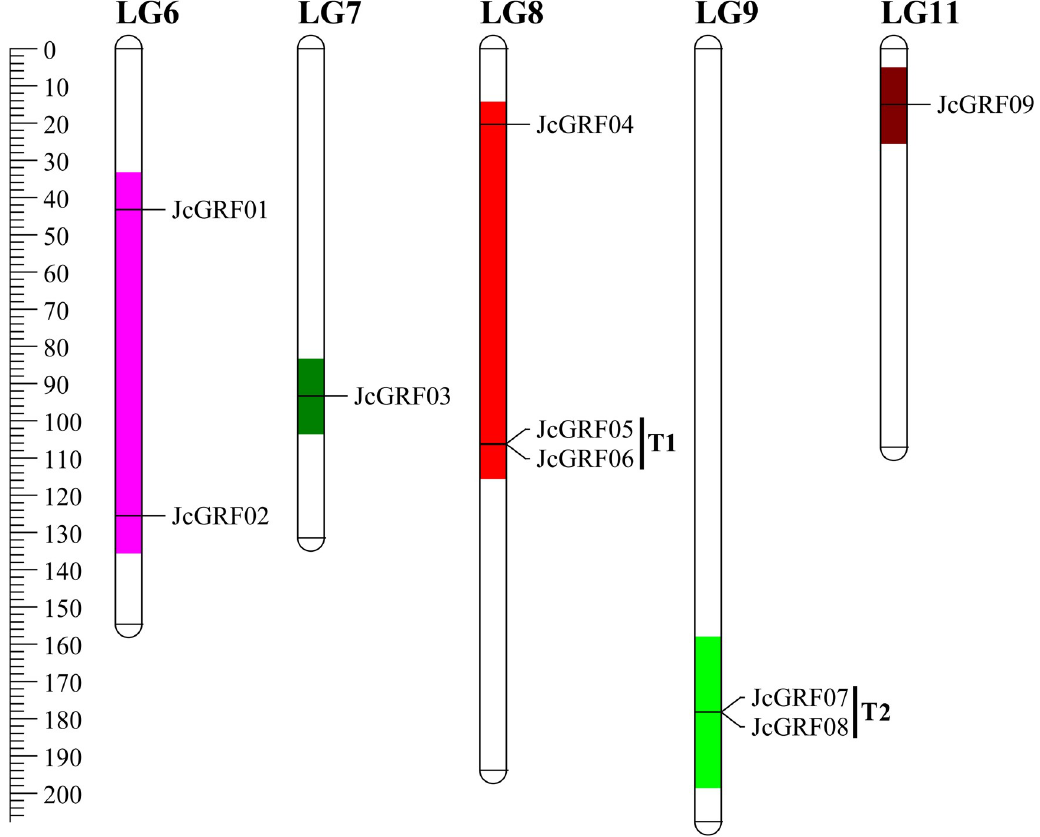
Fig 4. Location of JcGRF genes on Jatropha curcas chromosome. The number of chromosomes is displayed at the top.